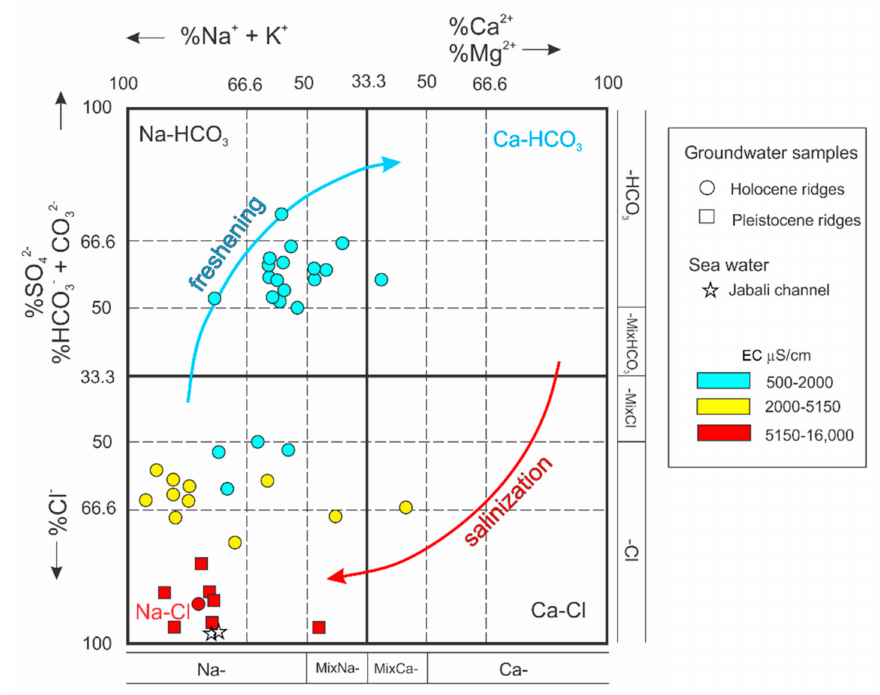
Figure 6. Hydrochemical facies evolution diagram, HFE-D